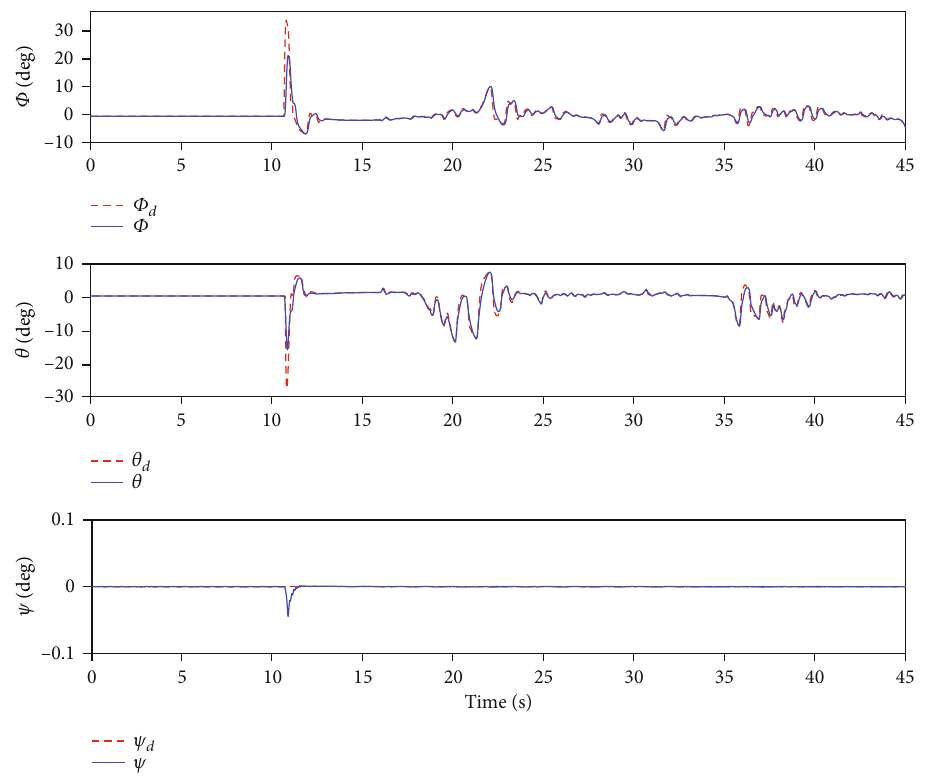
Figure 21: Pro fi les of the attitude of the quadrotor: rotational variables ð Φ , θ , ψ Þ : fl ight scenario